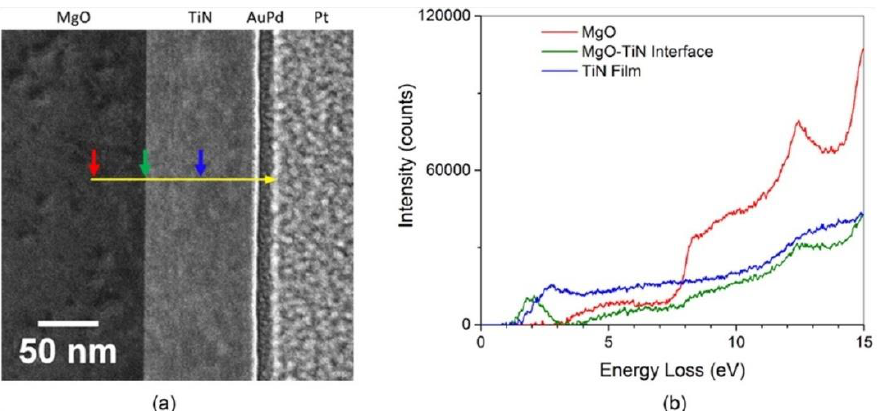
Figure 13. Using a combination of EELS with Scanning Tunneling Electron Microscopy (STEM) high-angle annular dark field (HAADF) imaging, Herzing et al. [168] determined the plasmon resonance characteristics of refractory TiN thin films. The spectra were collected by traversing ( a ) the yellow line from the MgO substrate through the TiN thin film, and to the opposite protective Pt layer. The spectra ( b ) are integrated over ten pixels at the locations of each colored arrow and indicate the local inelastic scattering distribution at said locations. From this, the spectral features typical of the MgO substrate are noted with an increase in inelastic scattering at 7.5 eV. At the interface of the MgO, and TiN film, a sharp peak due to surface-plasmon scattering is observed. A bulk plasmon resonance is identified at 2.81 eV and a weaker surface plasmon resonance peak was detected at 2.05 eV. The results are further supplemented by comparisons to finite difference time-domain simulations based on the measured optical data, which provide bulk and surface plasmon resonances with reasonable agreement at 2.74 eV and 2.15 eV, respectively. Reprinted with permission from Ref [168] Copyright Elsevier